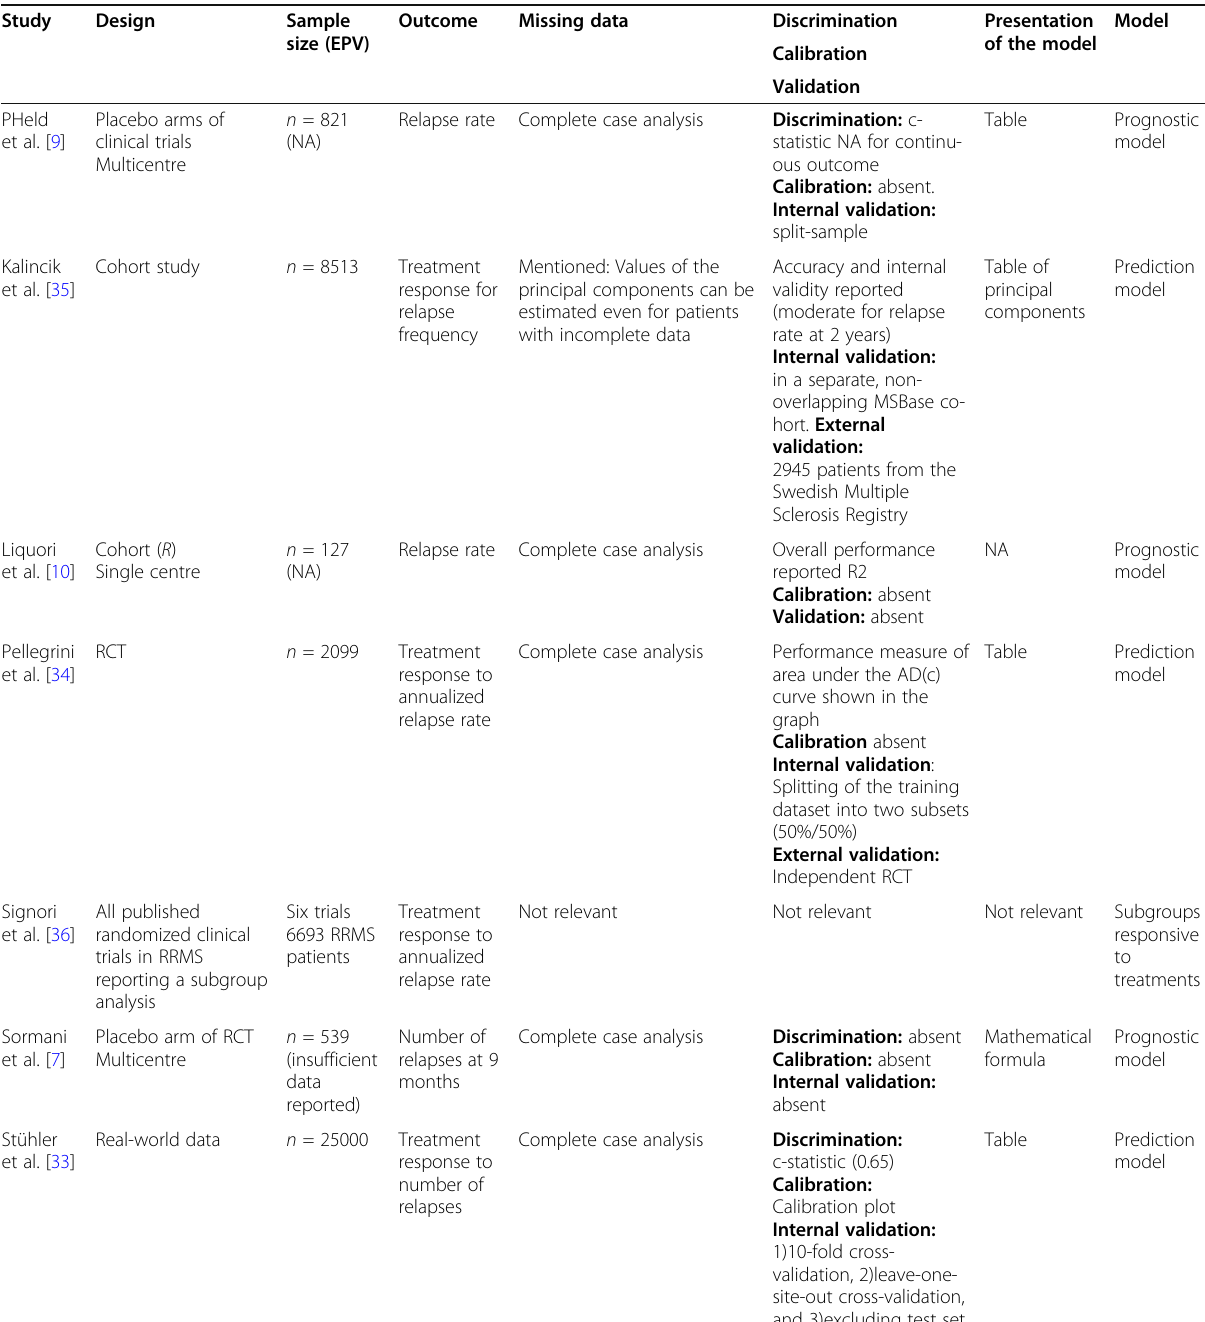
Table 5 Characteristics of the studies used to inform the developed prognostic model